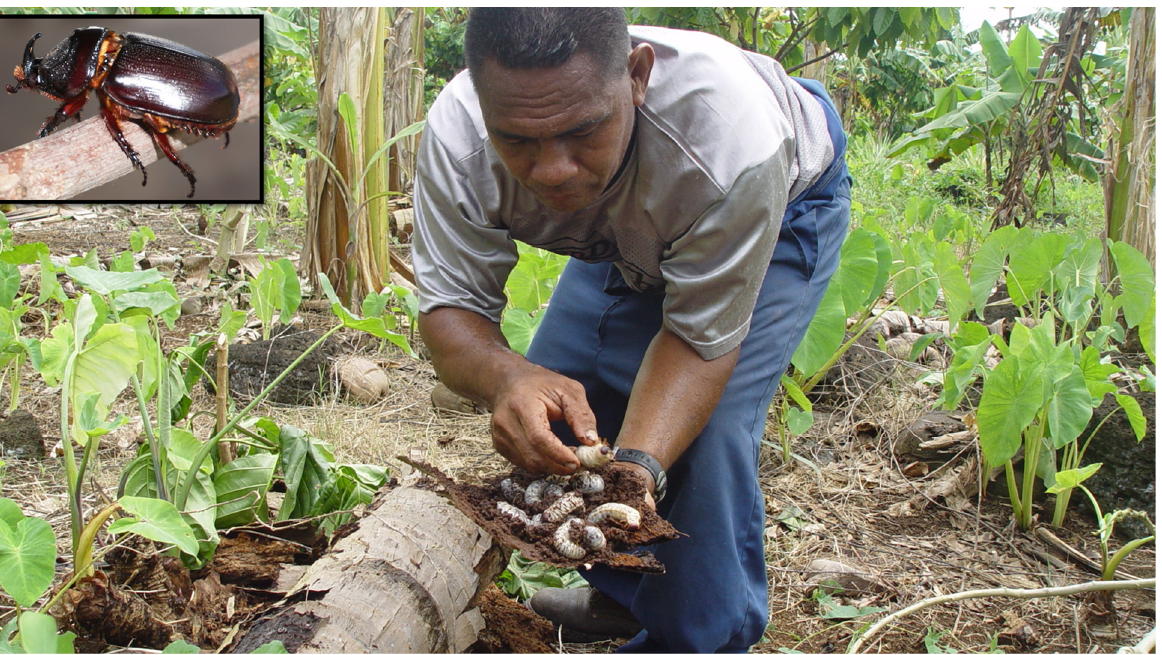
Figure 1. Collection of CRB ( Oryctes rhinoceros ) larvae from a rotting palm trunk in Samoa. Insert (top left) shows the adult beetle.